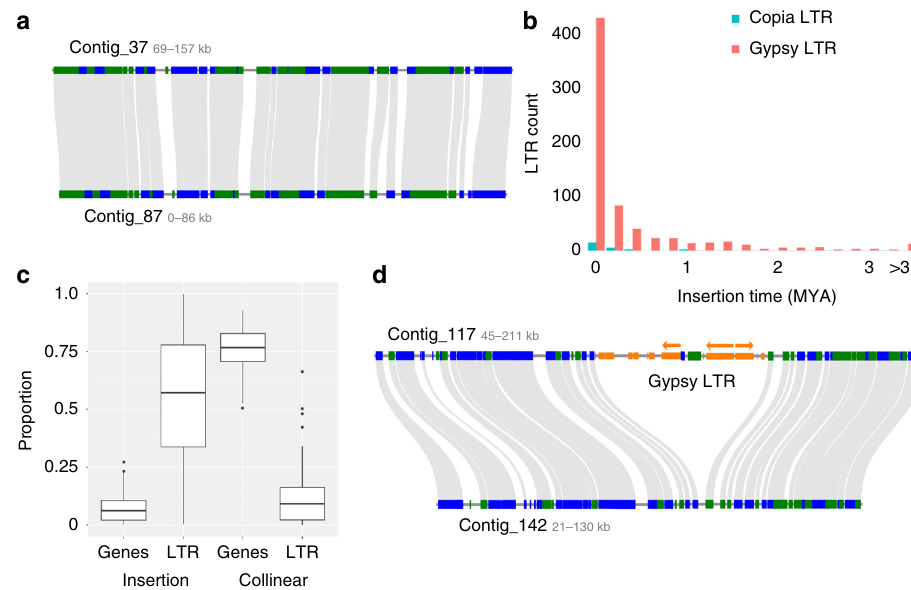
Fig. 2 Extensive haplotype-speci fi c LTR retrotransposon accumulation and deletion. a Typical micro-collinearity between two S. lepidophylla haplotypes. b Estimated insertions times of intact Copia and Gypsy LTR retrotransposons. c Composition of haplotype speci fi c and paired collinear regions. The proportion of genes and LTRs in the 105 manually curated insertions (left) and fl anking collinear regions (right) are plotted. d Micro-collinearity between two haplotypes showing a large 57 kb deletion in contig 142. Green and blue bars delineate gene orientation. Predicted LTR elements are depicted in orange and the three complete Gypsy LTRs are denoted by arrows. The three complete Gypsy LTRs have insertion times of < 0.1